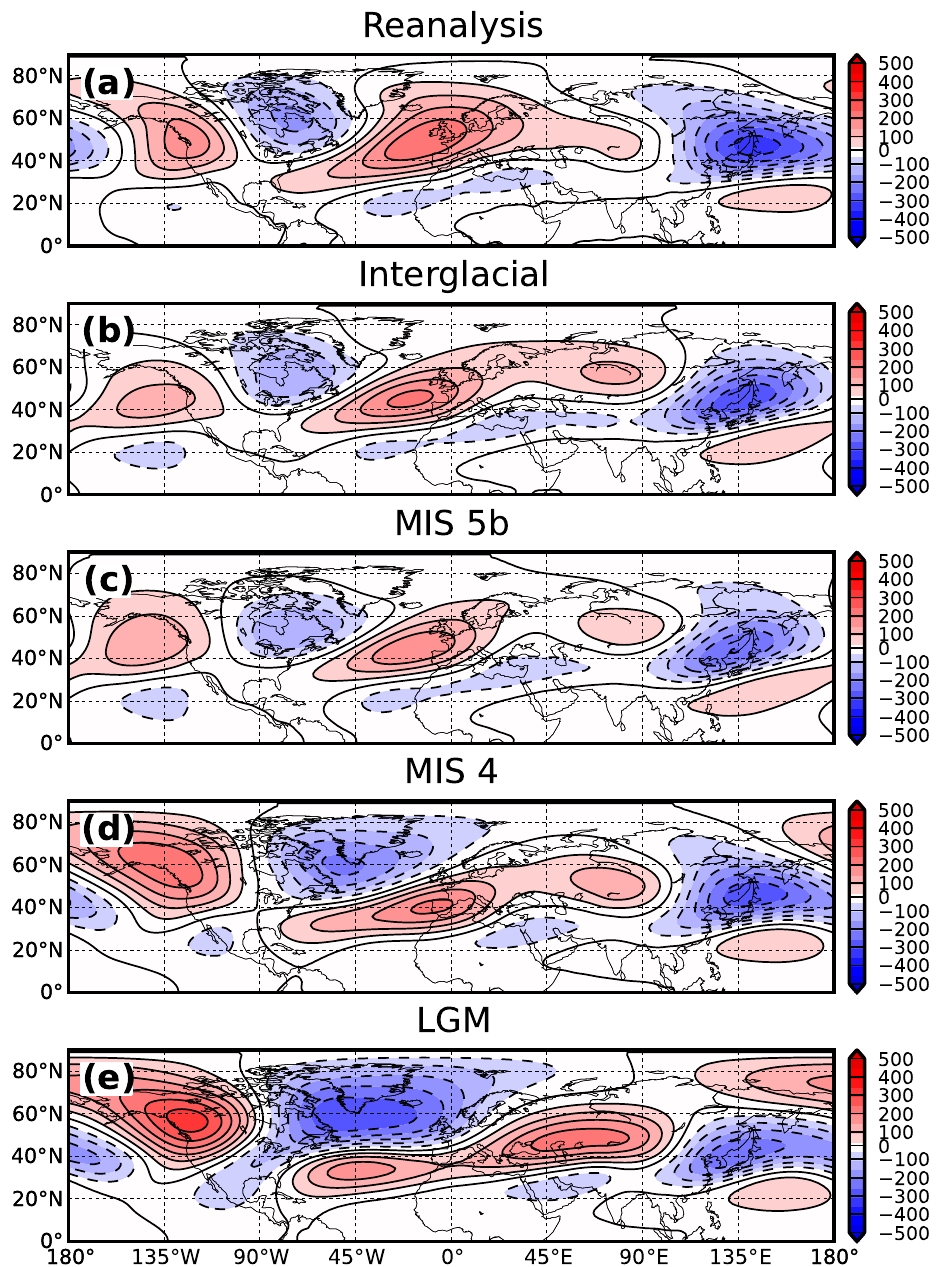
Figure 3. The 300hPa eddy geopotential field averaged over the winter months (DJF). The contour interval is 50m. Note the zonalisation of the geopotential height gradient over the Atlantic Ocean in the LGM